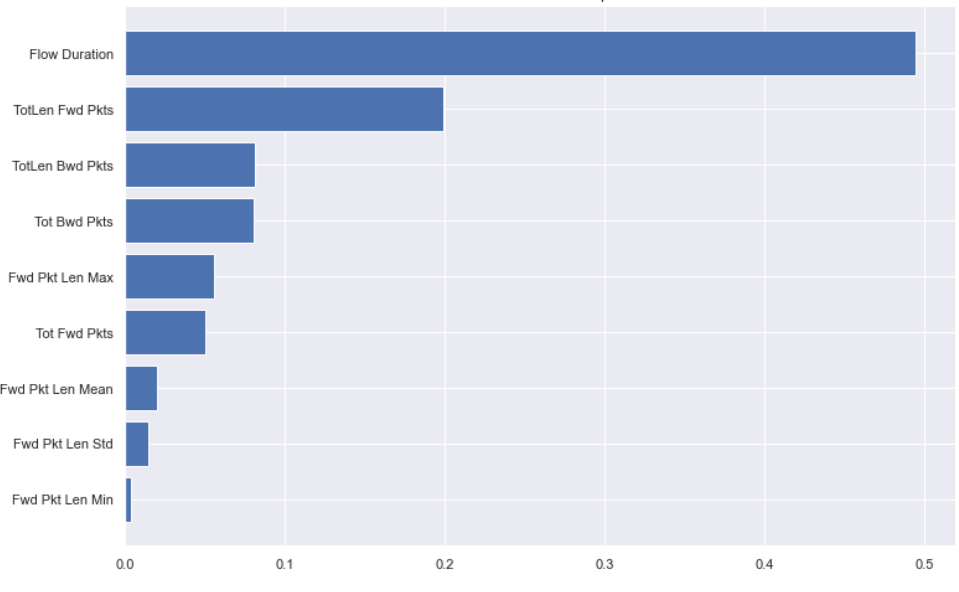
Figure 2. Feature importance extracted from the CICIDS2017 dataset using